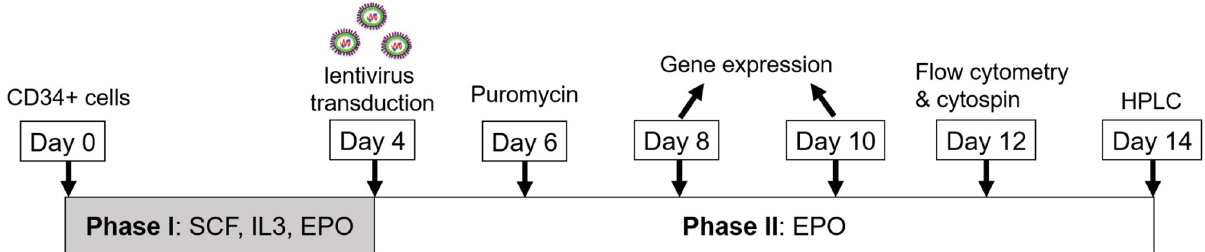
Fig 1. A methodological scheme illustrates the culture of CD34 + cells, lentiviral transduction conditions, erythroid differentiation protocols, and timeframes for gene expression, morphology, and HPLC studies.